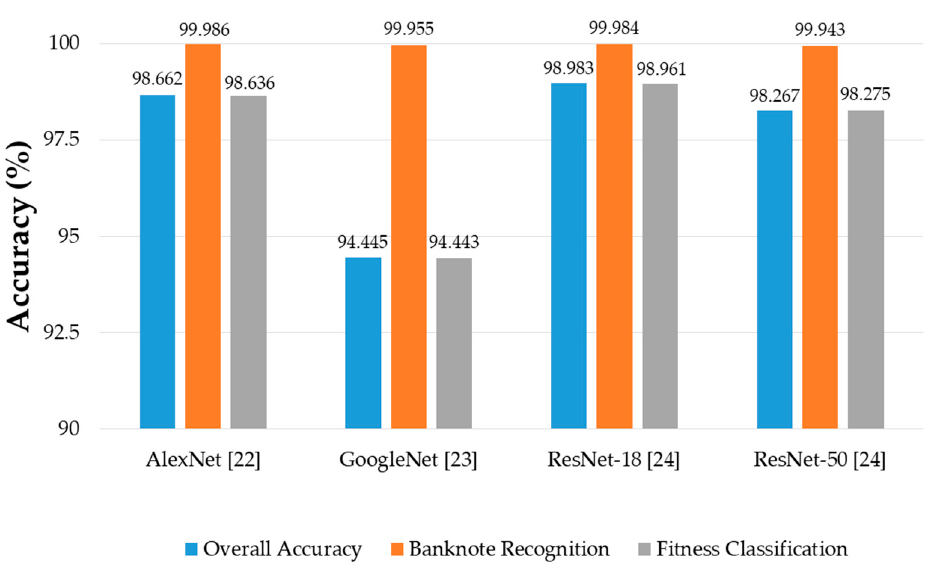
Figure 13. Average testing accuracy of five-fold cross-validation with overall accuracy and accuracy calculated separately for banknote recognition and fitness classification using various CNN architectures with models trained from